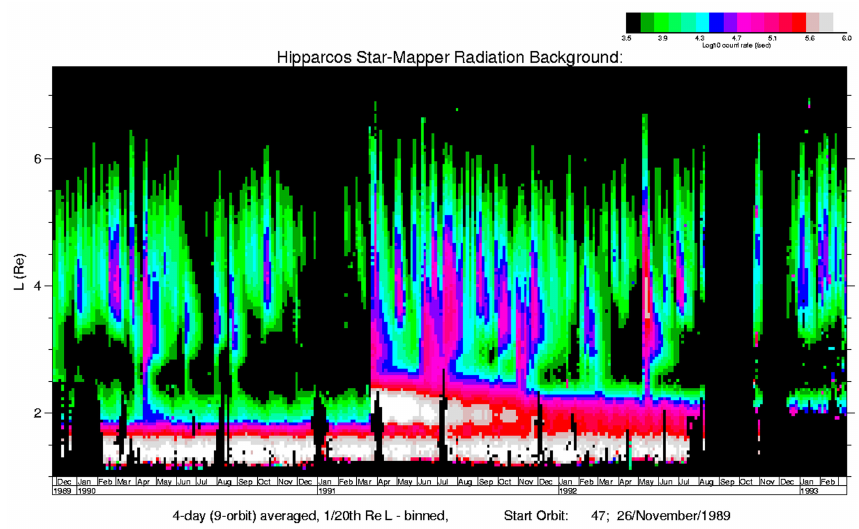
Fig. 1. One key area affected by space weather is other scientific research in space. This figure shows noise induced in the star-mapper on ESA’s Hipparcos astronomy mission (Daly et al., 1994). Due to launch problems, Hipparcos ended up on a elliptical orbit through the radiation belts. The radiation background is ordered by the McIwain L parameter. The resulting pattern is similar to that of high-energy electrons in the radiation belt, suggesting that these are the source of that background. Courtesy ESA (E. Daly).